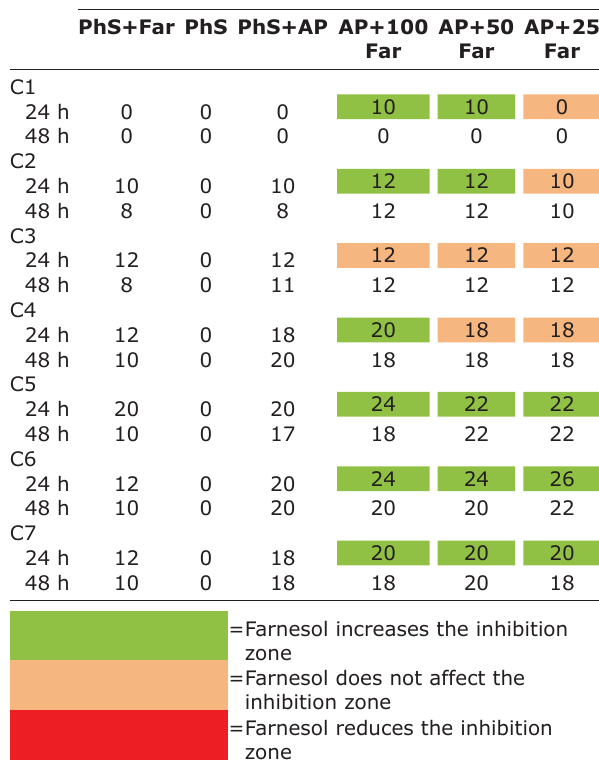
Table-2: Amphotericin-B sensitivity determination of 7 Candida albicans strains and the effect of farnesol three concentrations on these